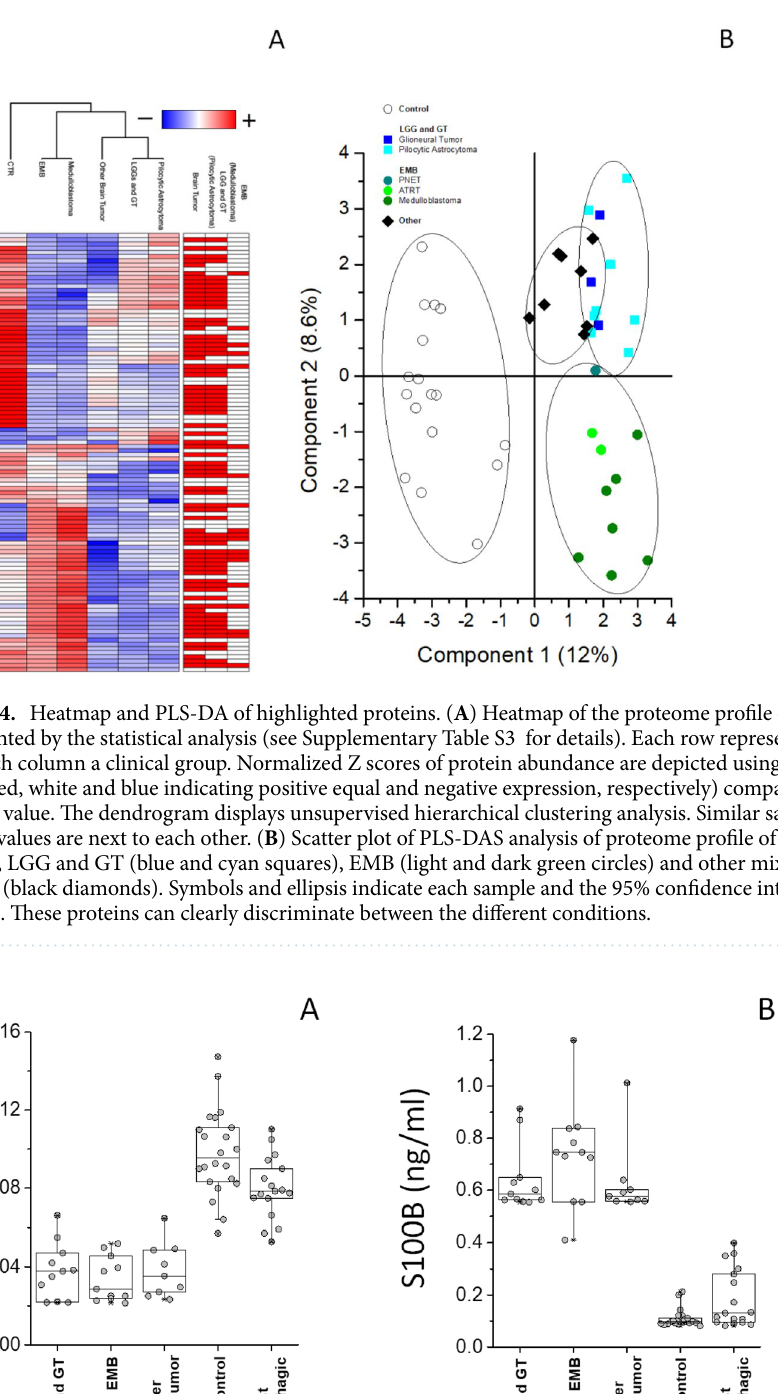
tumors. ELISA data correlate with MS data, however with a lower fold change, as MS displays a wider dynamic range. TAF15 and S100B, were the best biomarkers to differentiate the tumor from the non-tumor conditions. Tumoral condition seems discriminative per se. Human TATA-box binding proteins are RNA-binding multi- functional proteins belonging to the FET family, that function in splicing and mRNA transport, and possess a potent transcriptional activation domain 24 . TAF15 is associated with RNA polymerase II, playing a role in role in